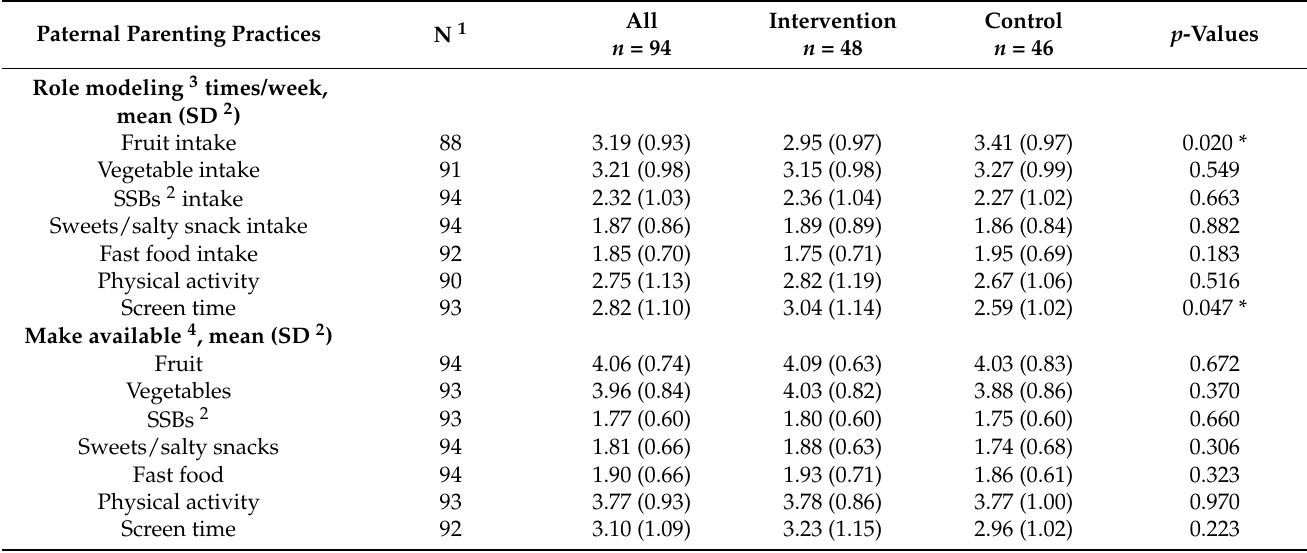
Table 2. Father-reported paternal parenting practices: Time-1 means and standard deviations for the intervention and delayed-treatment control groups ( n = 94).